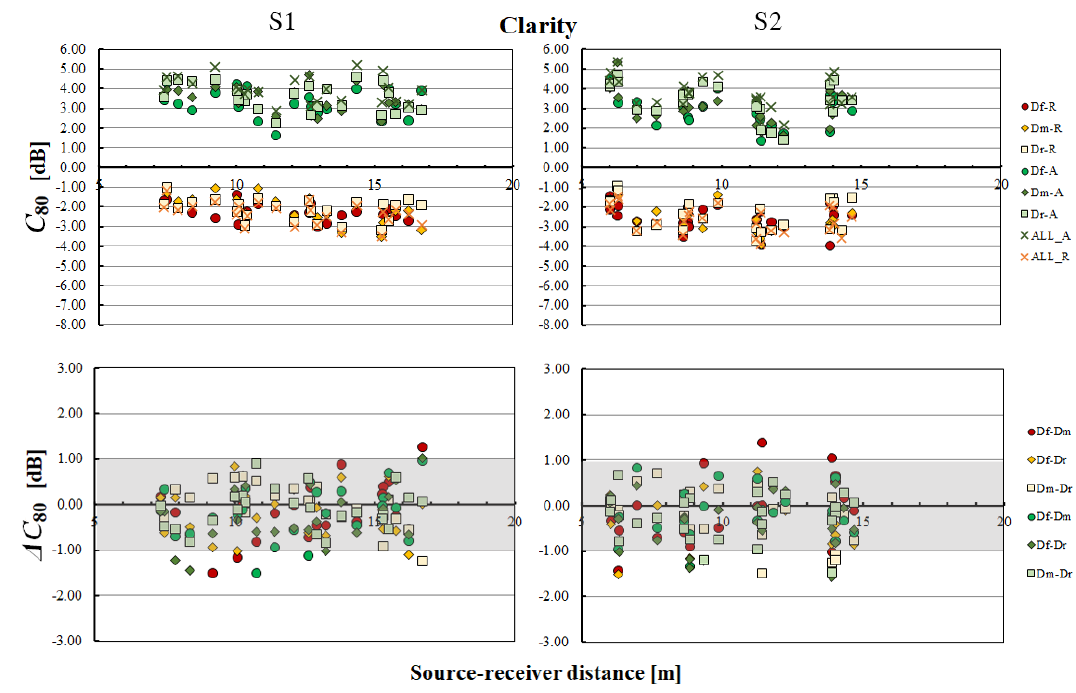
Figure 7. C 80 parameter averaged over 500 Hz and 1000 Hz for S1 and S2 source-to-receiver distance. Δ C 80 represents the parameter differences between the configurations Df-Dm, Df-Dr, Dm-Dr in the reflective (-R) and absorptive (-A) conditions. Differences equal ±1 JND of the parameters are highlighted through a gray area.